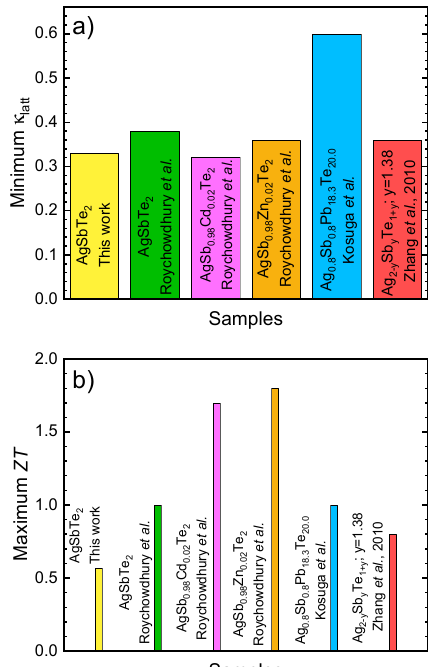
Figure 6. ( a ) Weighted mobility and ( b ) thermoelectric figure of the merit for the arc-melted AgSbTe 2 compound.